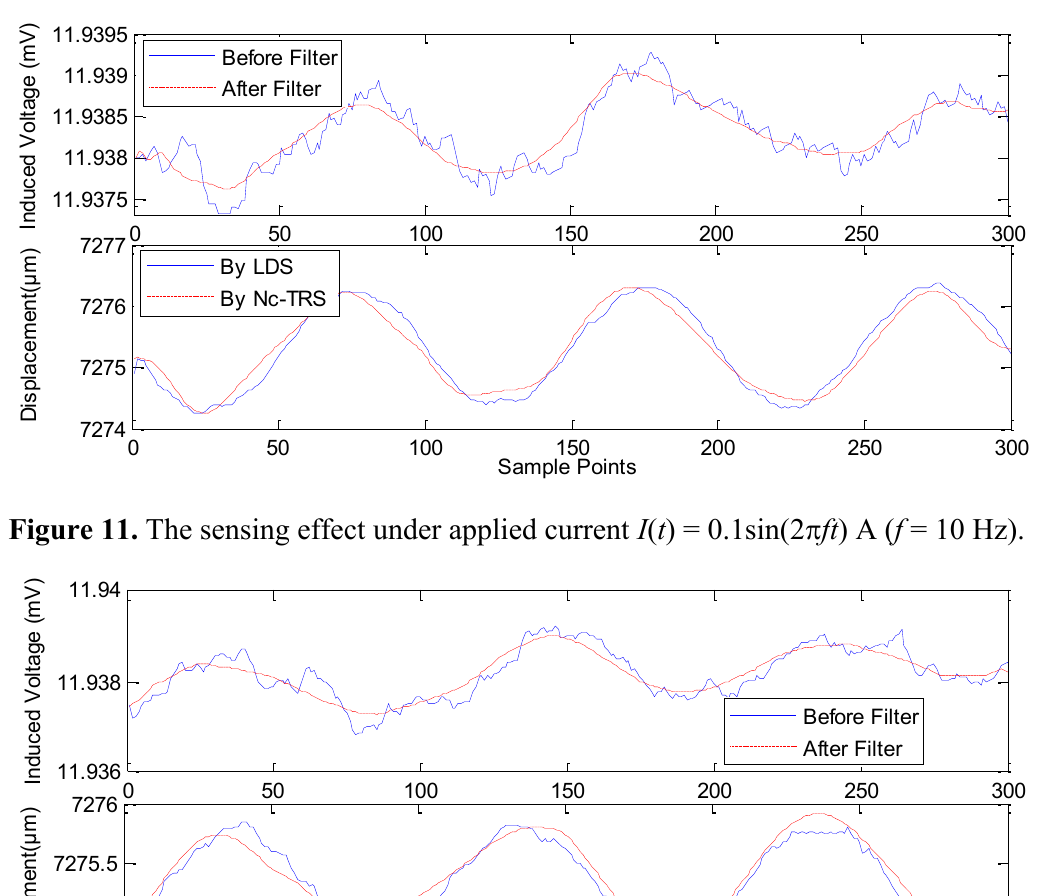
Figure 10. The sensing effect under applied current I ( t ) = 0.2sin(2  ft ) A ( f = 10 Hz).